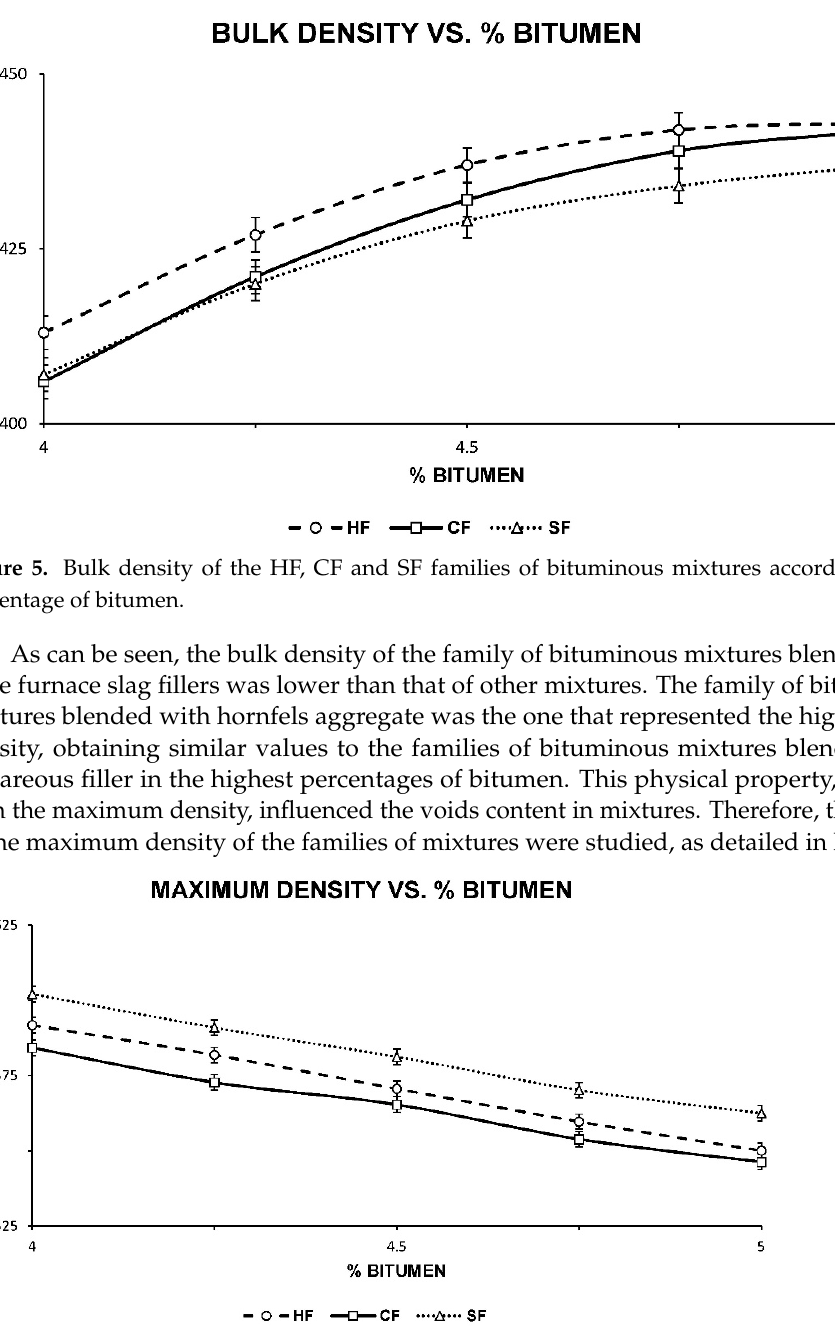
Figure 7. Void content of the HF, CF and SF families of bituminous mixtures as a percentage of bitumen.